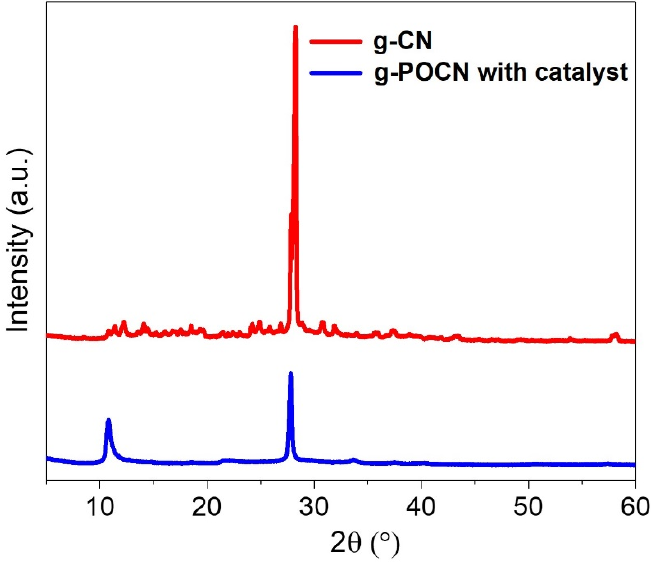
Figure 2. PXRD spectra of g-CN and Zn-catalyzed g-POCN.